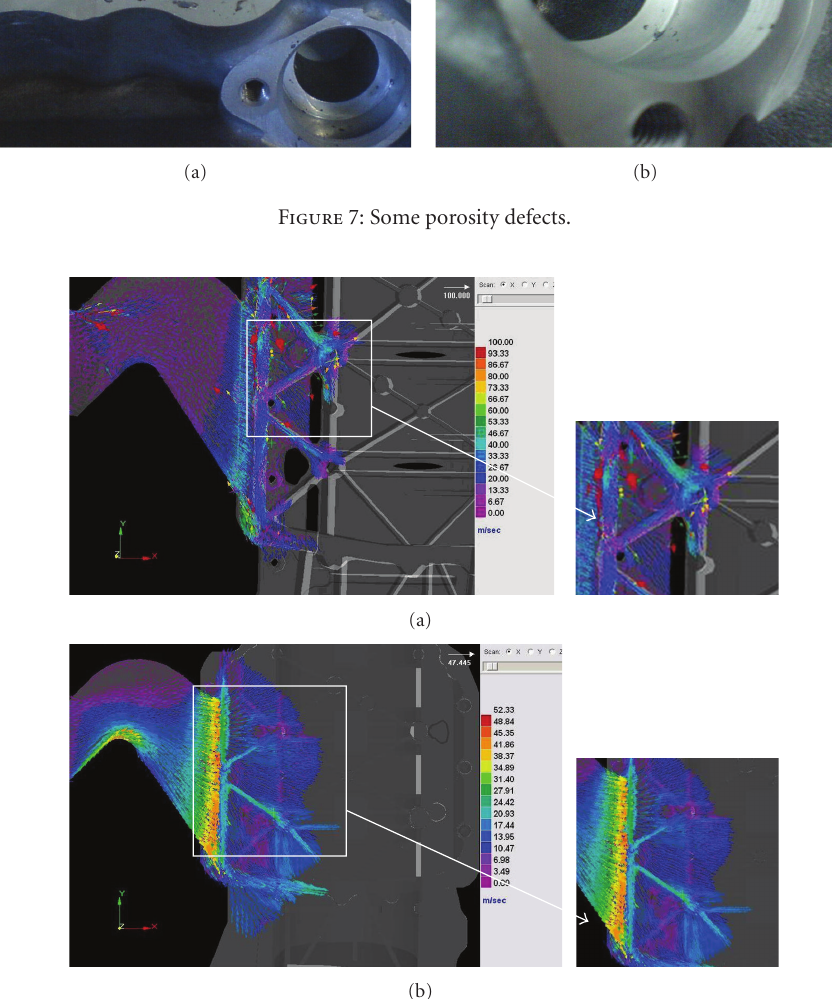
Figure 8: Velocity vectors of the melt at the three holes in the front of the